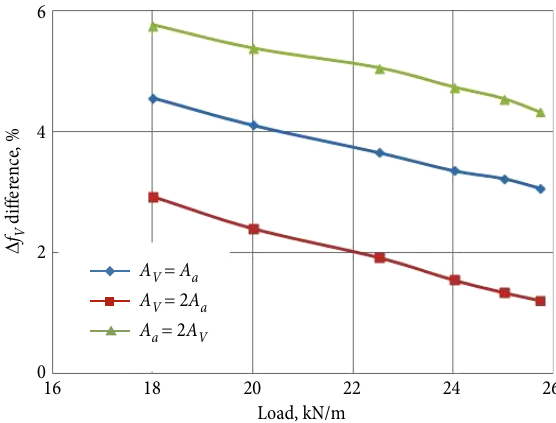
Fig. 7. The difference of the vertical displacement (in times) in the middle of the stress-ribbon structure and stress-ribbon structure with external tendon span